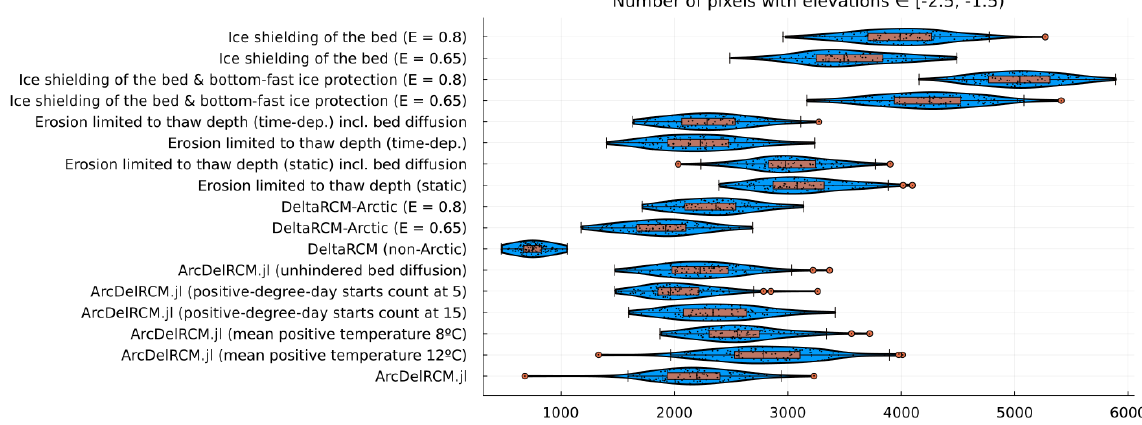
Figure 7. An analogous plot to Fig. 6 but showing the number of pixels with elevation ∈ [− 2 . 5, 1.5)m. Since the modelled ramp feature that forms under h ice , max = 2m lies mostly in this elevation range, we use this value as a proxy for the size of the ramp, even though it inevitably includes delta pixels that are not part of a ramp feature but happen to be in the same elevation range. This is evident when comparing the DeltaRCM-Arctic ( E = 0 . 8) and ArcDelRCM.jl cases with Fig. 5a and b. The pixels with the relevant elevations are more concentrated around channel outlets in the former, while they are more distributed along the delta shore in the latter (forming the ramp).